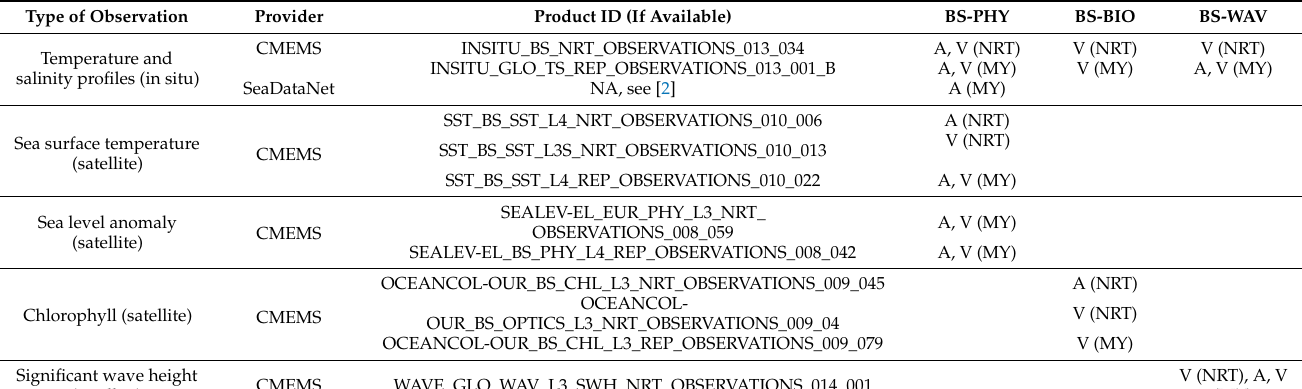
Table 1. Upstream data dependency for the BS-MFC: for each type of observation, provider and product ID are given as well as the BS component—PHY, BIO, WAV—and product category—NRT and MY—which up-take it for assimilation (A) and/or validation (V).